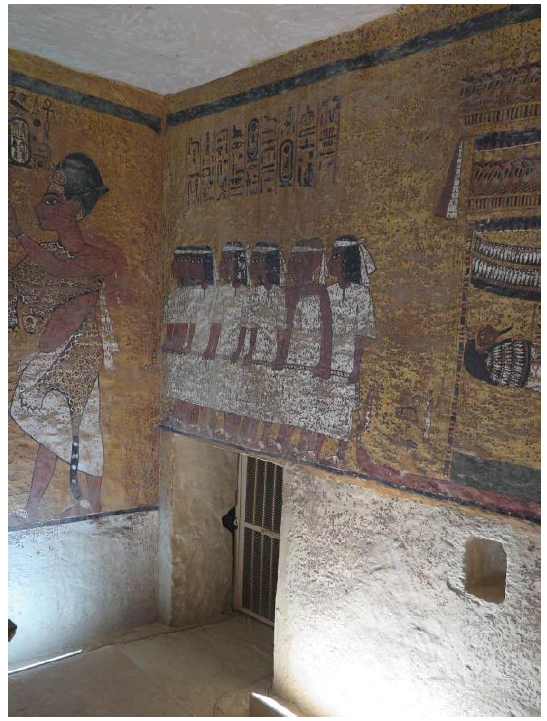
Figure 6. The northeast corner of the burial chamber of the facsimile of the tomb of Tutankhamen © J. Paul Getty Trust